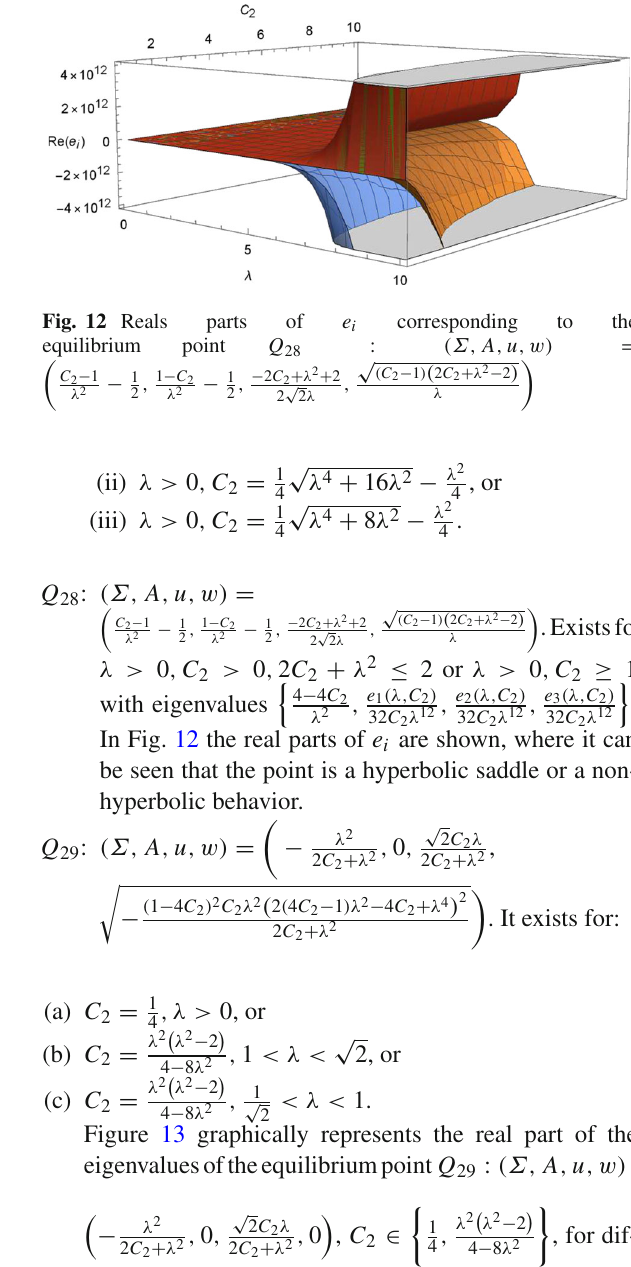
ferent choices of the parameter λ . This figure illustrates that the point has a general saddle